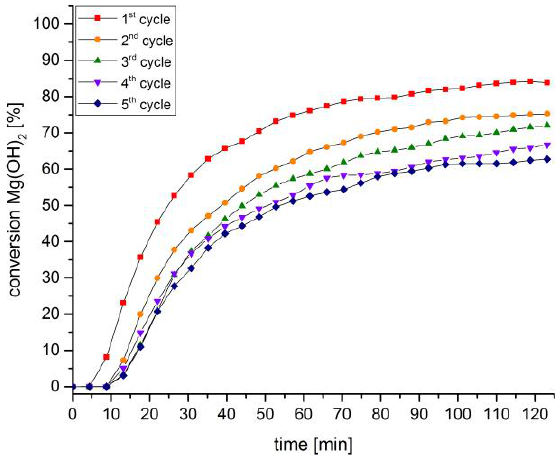
Figure 5. Cycle stability of MgCO 3 -originating MgO CO 3 -4.